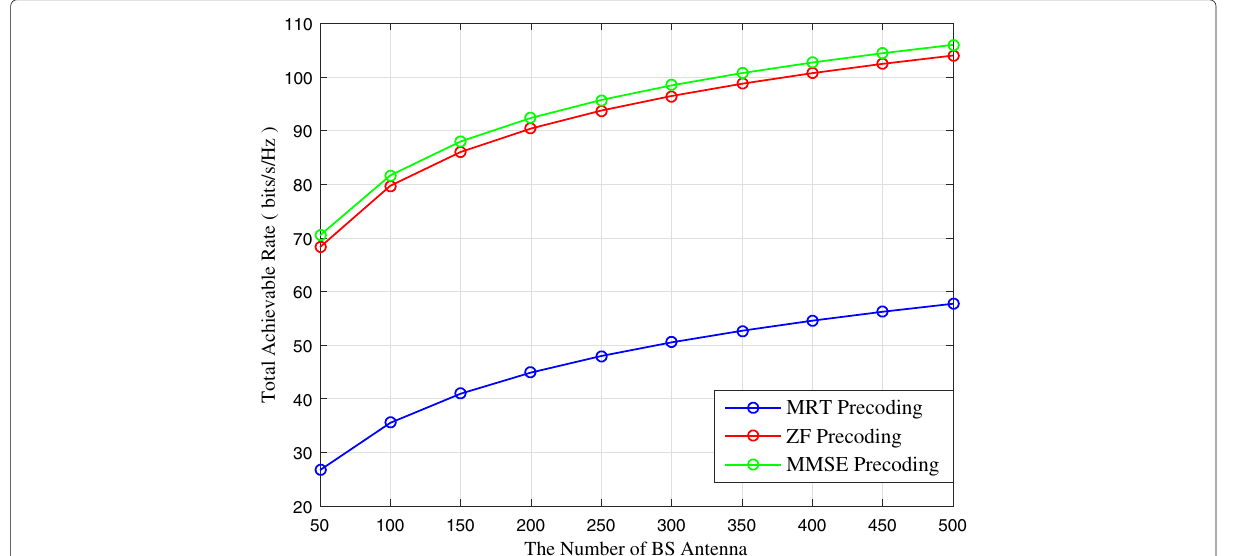
Fig. 3 Comparison of the total achievable rate versus the number of BS antennas for MRT, ZF, and MMSE precoding schemes. Results are shown for SNR ρ = 5 dB and K =